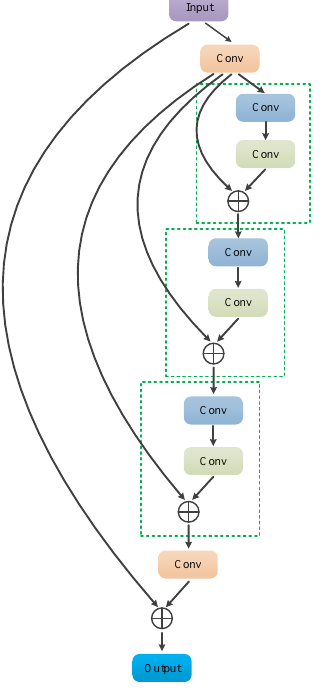
Figure 6. Structure of the recursive residual